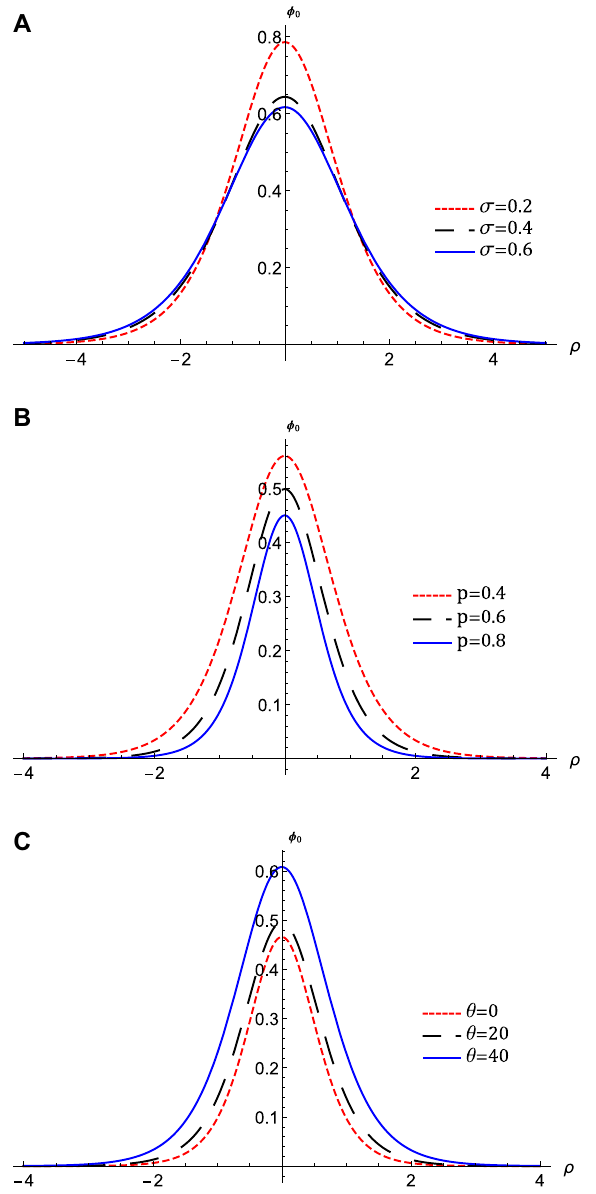
Figure 4. The variation of the QIASWs potential φ 0 that represented by equation ( 16 ) against ρ at ω = 0.5 , M = 0.4 , ( A ) for different values of σ with p = 0.1 , θ = 1 , H with σ = 0.4 , θ = 1 , H e = 0.1 , and H p = 0.6 , ( C ) for different values of θ with p = 0.7 , σ = 0.4 , H e = 0.1 , and H p = 0.6 , ( D ) for different values of H e with p = 0.7 , σ = 0.4 , θ = 1 , and H p = 0.6 , ( E ) for different values of H p with p = 0.7 , σ = 0.4 , θ = 1 , and H e = 0.6